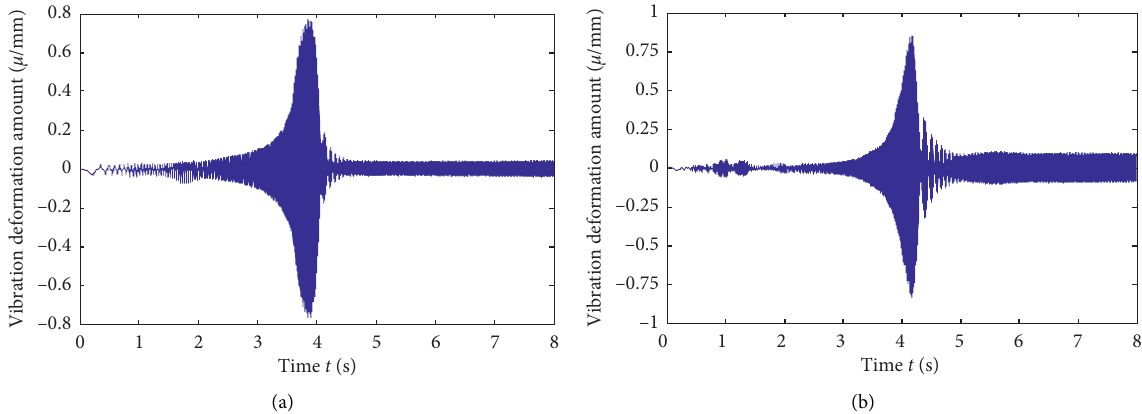
Figure 12: Effect of the position of support II on the vibration deformation of the shafting across the first-order critical speed. (a) Supports’ positions 0 mm, − 40mm, 0mm. (b) Supports’ positions 0mm, 40mm, 0